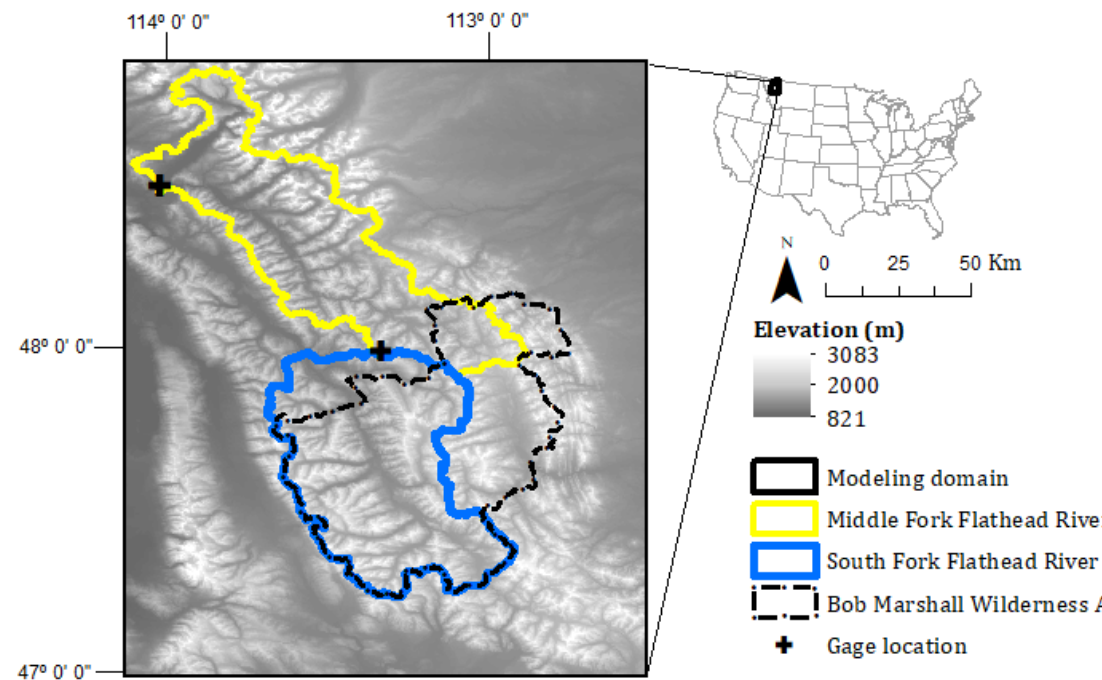
Figure 1. Digital elevation map of the study area. Domain for modeling leaf area index (LAI) is shown by the outer rectangle; domains for time series analysis of LAI and evapotranspiration are the South Fork Flathead River and Middle Fork Flathead River watersheds (outlined in blue and yellow, respectively). well as comparison of plot-scale vs. gridded LAI